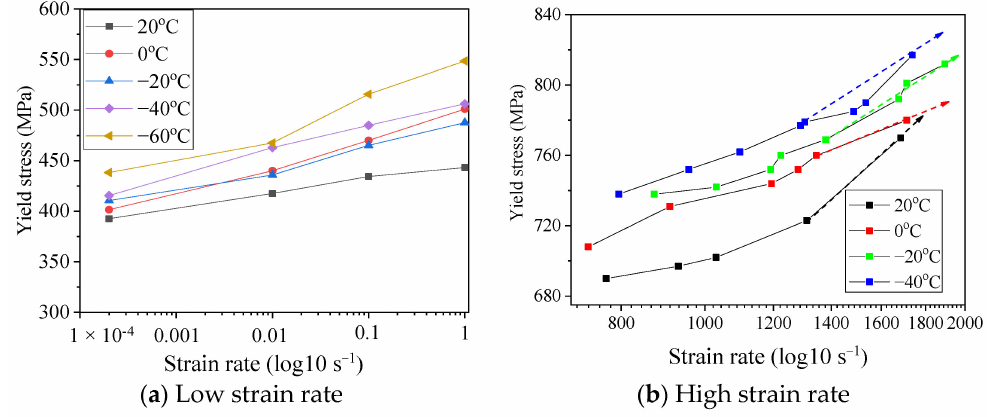
Figure 13. Yield stress at different